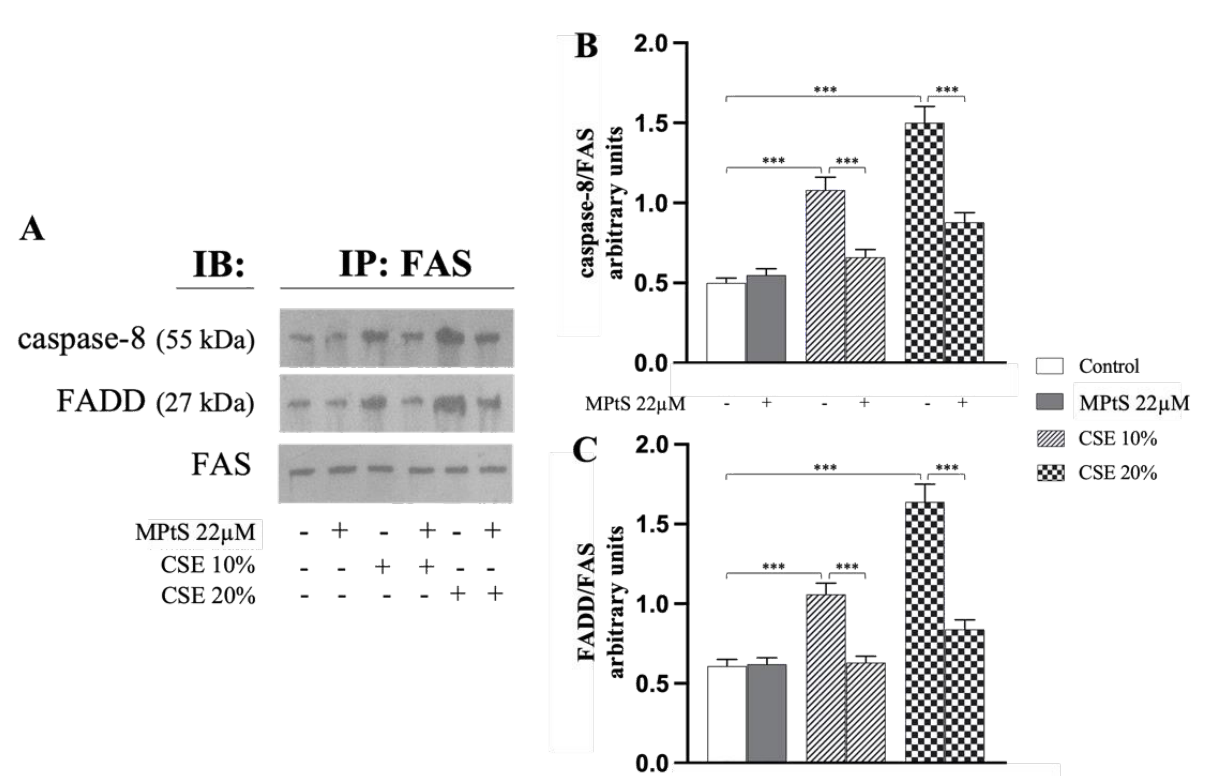
Figure 4. Mixture of plant sterols (MPtS) inhibits cigarette smoke extract (CSE)-induced extrinsic eryptosis. ( A ) Representative images of immunoblotting analysis of caspase 8 and FAS-associated via death-domain (FADD) after immunoprecipitation with anti-FAS antibody in 10% or 20% CSE-treated RBCs incubated for 4 h in absence or in co-treatment with 22 µ M MPtS. Protocol of analysis at Sections 4.6 and 4.7. ( B , C ) densitometric analysis of caspase 8 and FADD levels normalized for FAS. Values are the means of bands’ densitometry of three separate experiments with comparable results carried out on the same blood sample. *** p < 0.001 (ANOVA associated with Tukey’s test).